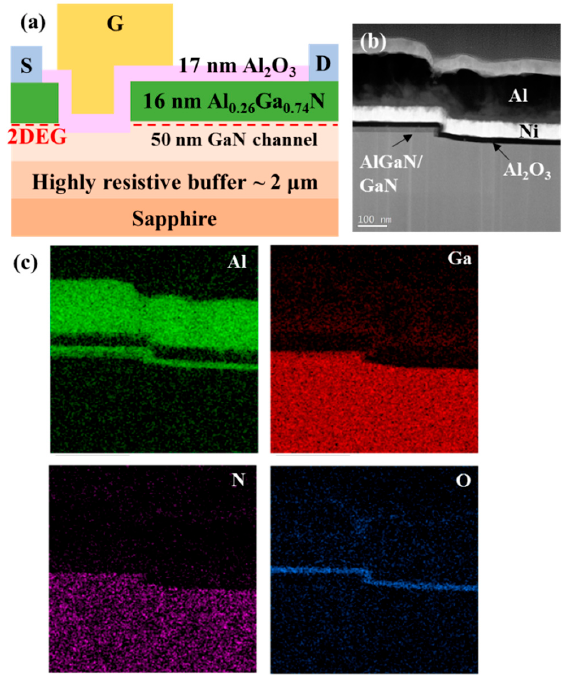
Figure 1. ( a ) Schematic illustration of a normally-off GaN metal-insulator-semiconductor field-effect transistor (MISFET) including epitaxial and device information. ( b ) Cross-sectional transmission electron microscopy (TEM) and ( c ) energy-dispersive X-ray spectroscopy (EDX) images of the recessed-gate GaN MIS structure. Elemental mapping of Al (green), GaN (red), N (purple), and O (blue) in the device structure obtained using the EDX machine.